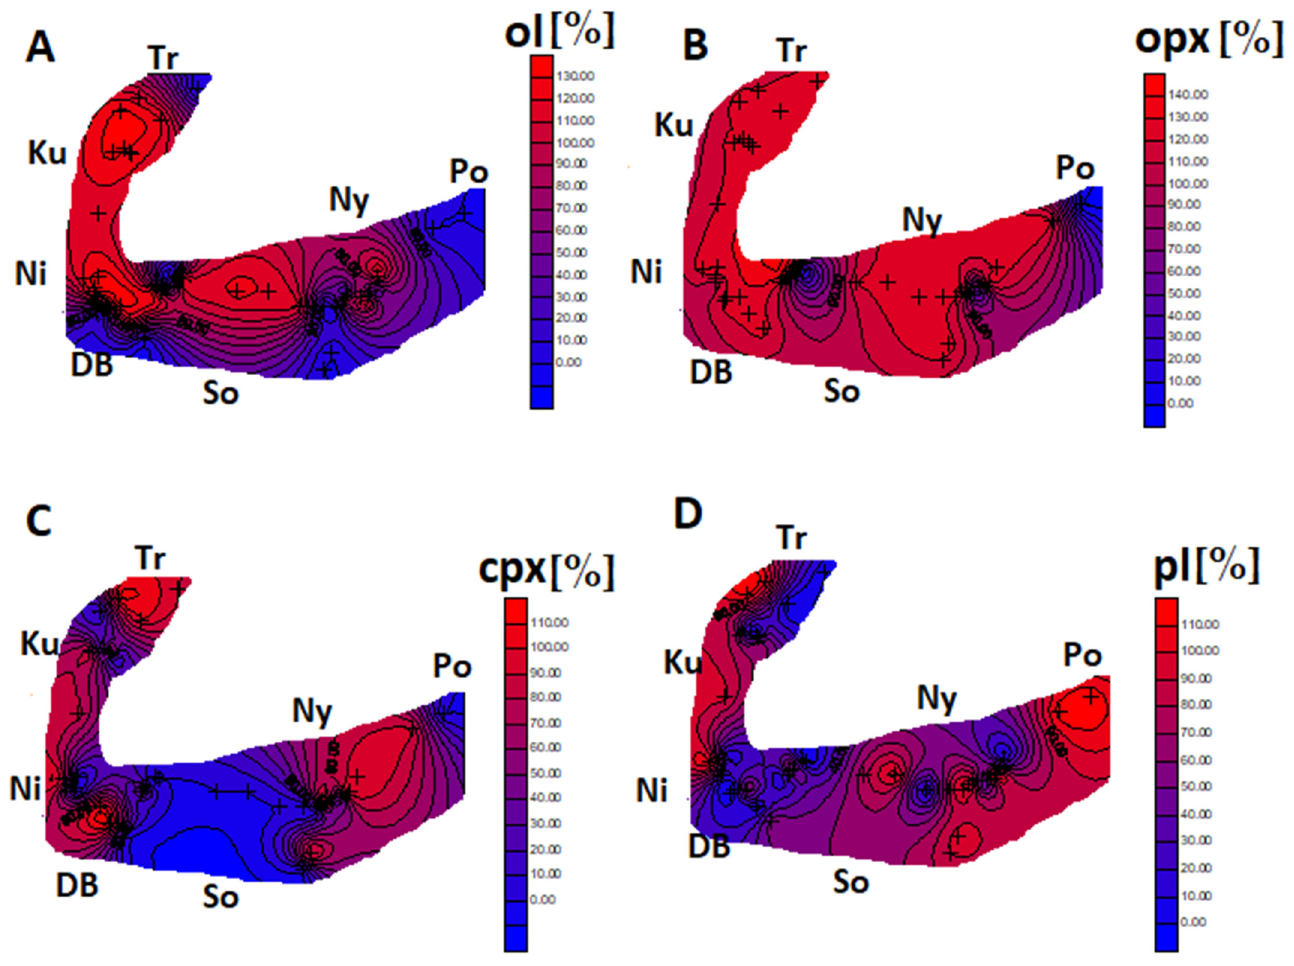
Figure 5. Maps of fractal dimension distribution for ( A ) olivines, ( B ) plagioclases, ( C ) orthopyroxenes, and ( D ) clinopyrox- enes. Abbreviations: Tr—Traviannaya; Ku—Kumuzhia; Ni—Nittis; DB—Dunite Block; So—Sopcha; Ny—Nyud; Po—Poaz. The scale in figures represents values from 0 to more than 130%, indicating the manner of complexity of the crystal boundary. A value of 100% is taken to be euhedral in shape; lower values indicate more spherical, simple forms, while higher values indicate strongly frayed crystals with an elaborate boundary. A value of 0% means there is no crystal in the rock sample under study.